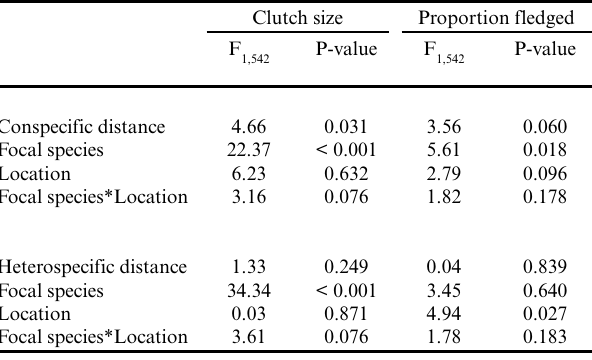
Table 3 . Results of GLMM analysis of variance to test the effects of distance between occupied nest boxes containing conspecific or heterospecifics together with the fixed effects of focal species (Blue Tit, Cyanistes caeruleus , or Great Tit, Parus major ), location (Riseholme Park or Treswell Wood), and the interaction on clutch size and proportion of the clutch that fledged. Distance values were Log -transformed prior to 10